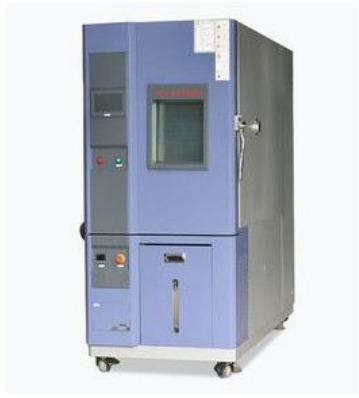
Figure 4. Rapid temperature to humidity test chamber.